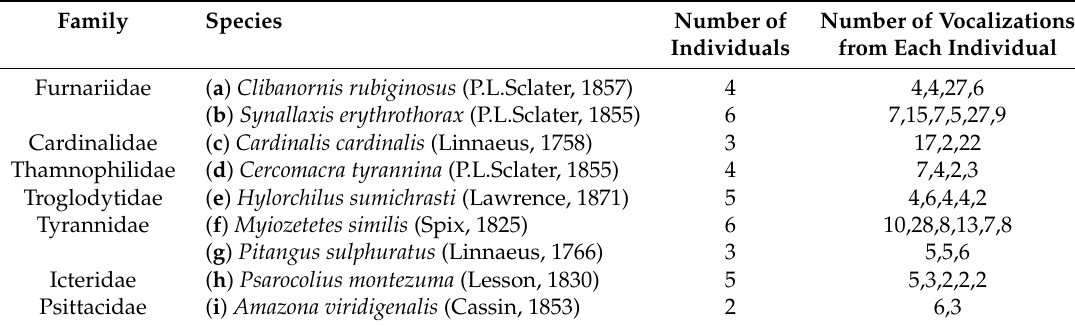
Table 1. List of bird species and records in the